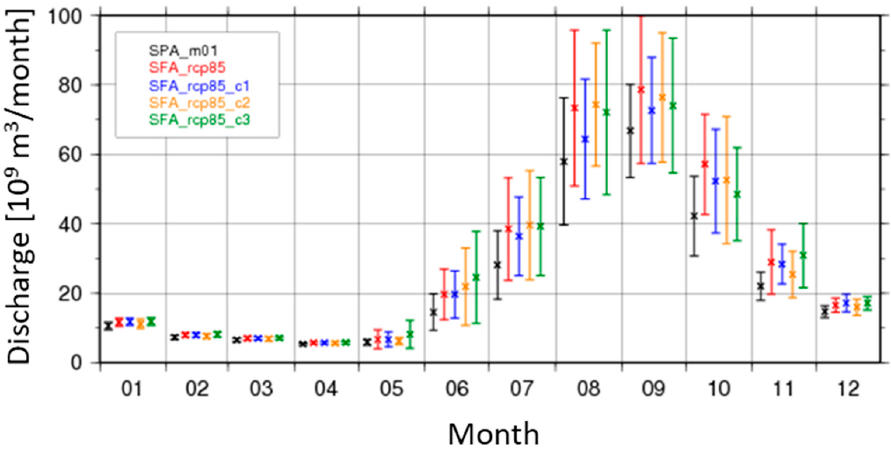
Figure 6. Monthly Kratie discharge variability for the considered present and future climatic durations (cross: 25-year average, bar: ±1 σ range).